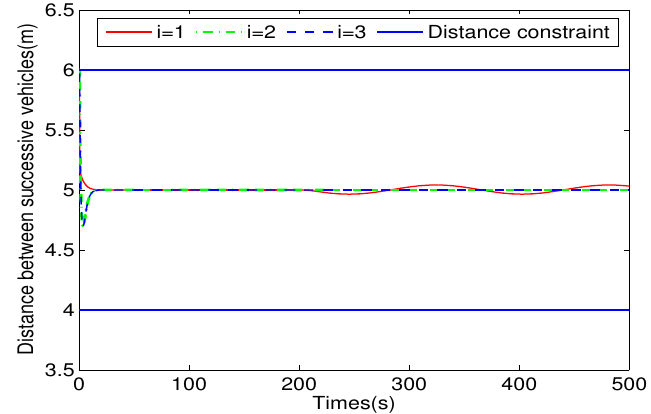
Figure 7. The line-of-sight (LOS) range d i , the maximum connectivity distance and minimum collision distance under model-based